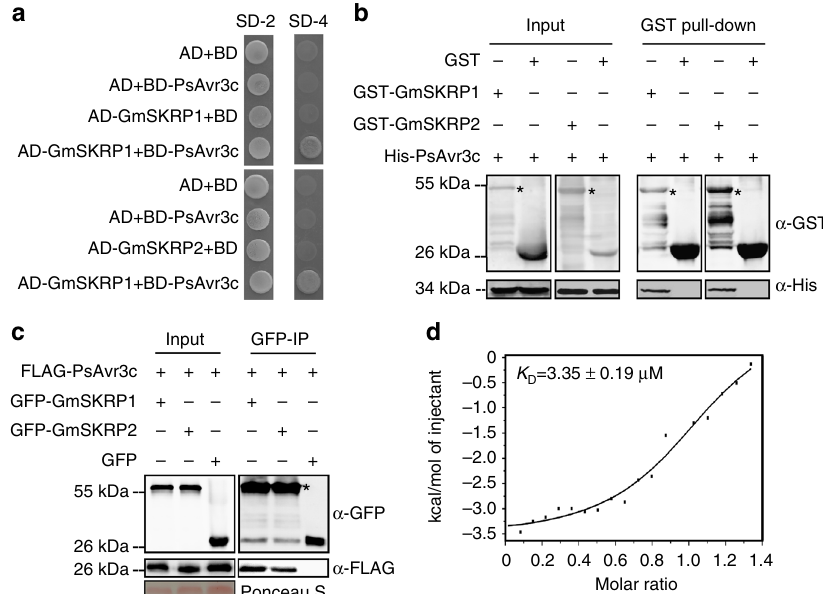
Fig. 2 PsAvr3c physically interacts with soybean GmSKRP1/2 in vitro and in vivo. a PsAvr3c interacts with GmSKRP1/2 in yeast. PsAvr3c and GmSKRP1/2 were cloned into bait plasmid pGBKT7 (BD) and prey plasmid pGADT7 (AD), respectively. Yeast transformants were grown on SD/-Trp/-Leu (SD-2) and selected on SD/-Trp/-Leu/-His/-Ade (SD-4). The plates were photographed 5 days after inoculation. Experiments were repeated three times with similar results. b PsAvr3c physically interacts with GmSKRP1/2 in vitro. GST-GmSKRP1/2 or GST bound resins were incubated with E . coli supernatant containing His-PsAvr3c. Protein bands of GST-GmSKRP1/2 are marked by asterisks. The presence of His-tagged proteins was detected by western blot using anti-His tag antibody. c PsAvr3c interacts with GmSKRP1/2 in vivo. Co-immunoprecipitations (IP) were performed in extracts of N . benthamiana leaves expressing both FLAG-PsAvr3c and GFP-GmSKRP1/2. The presence of FLAG proteins was detected by western blot using anti-FLAG antibody. The GFP-GmSKRPs protein bands are indicated by asterisks and the protein loading is indicated by Ponceau stain. d Measuring binding af fi nity between PsAvr3c and GmSKRP1 in vitro. The binding af fi nity was determined using isothermal titration calorimetry (ITC). The raw titration data were integrated and fi tted to a one-site binding model using the MicroCal PEAQ-ITC analysis software. Three original measurement results are 3.38, 3.52 and 3.14 μ M, K D = 3.35 μ M is